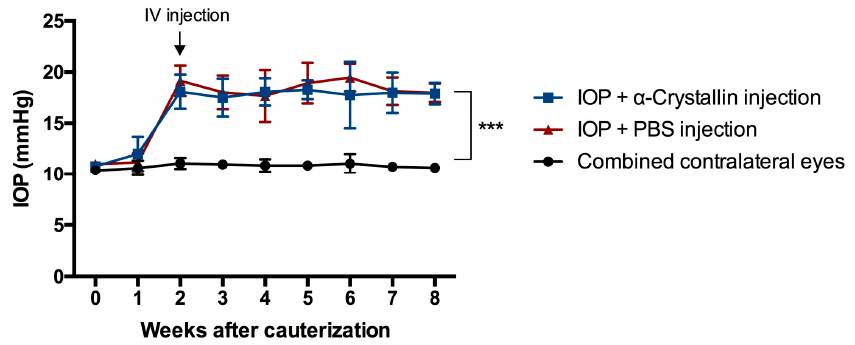
Figure 1. IOP elevation as a result of the episcleral vein cauterization. The intraocular pressure (IOP) of all cauterized eyes rose significantly (*** p < 0.001, n = 11, mean ± SD, parametric t -test) two weeks after the surgical intervention. With rise of the IOP, the intravitreal (IV) injection of α -crystallin B and PBS was performed. No noticeable influence on the IOP was observed due to the injection. The untreated contralateral eyes remained unaffected in terms of IOP